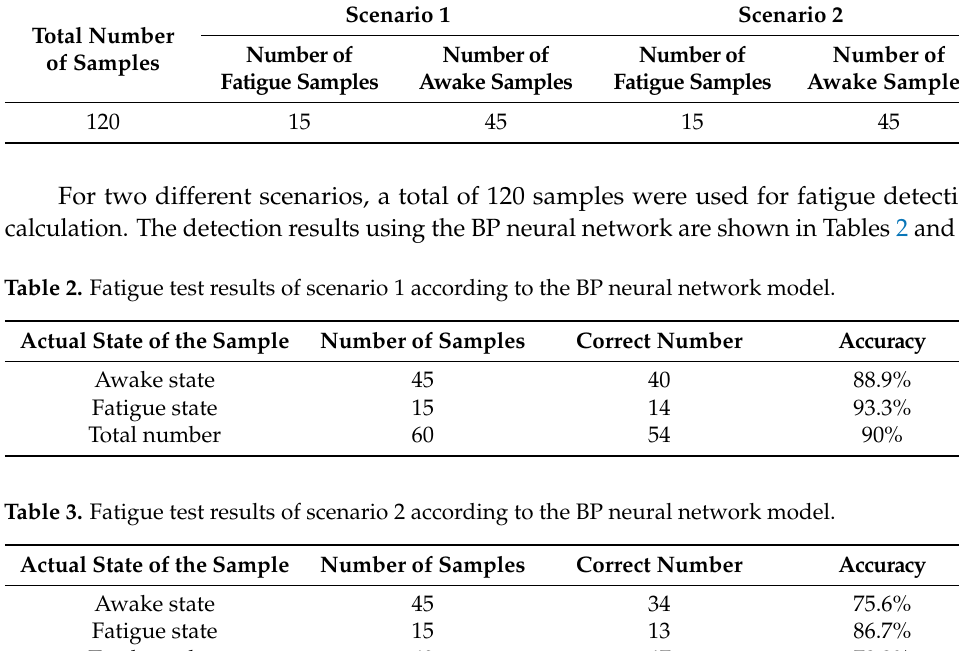
Table 1. Composition of test dataset used for the BP neural network model. Total Number of Samples